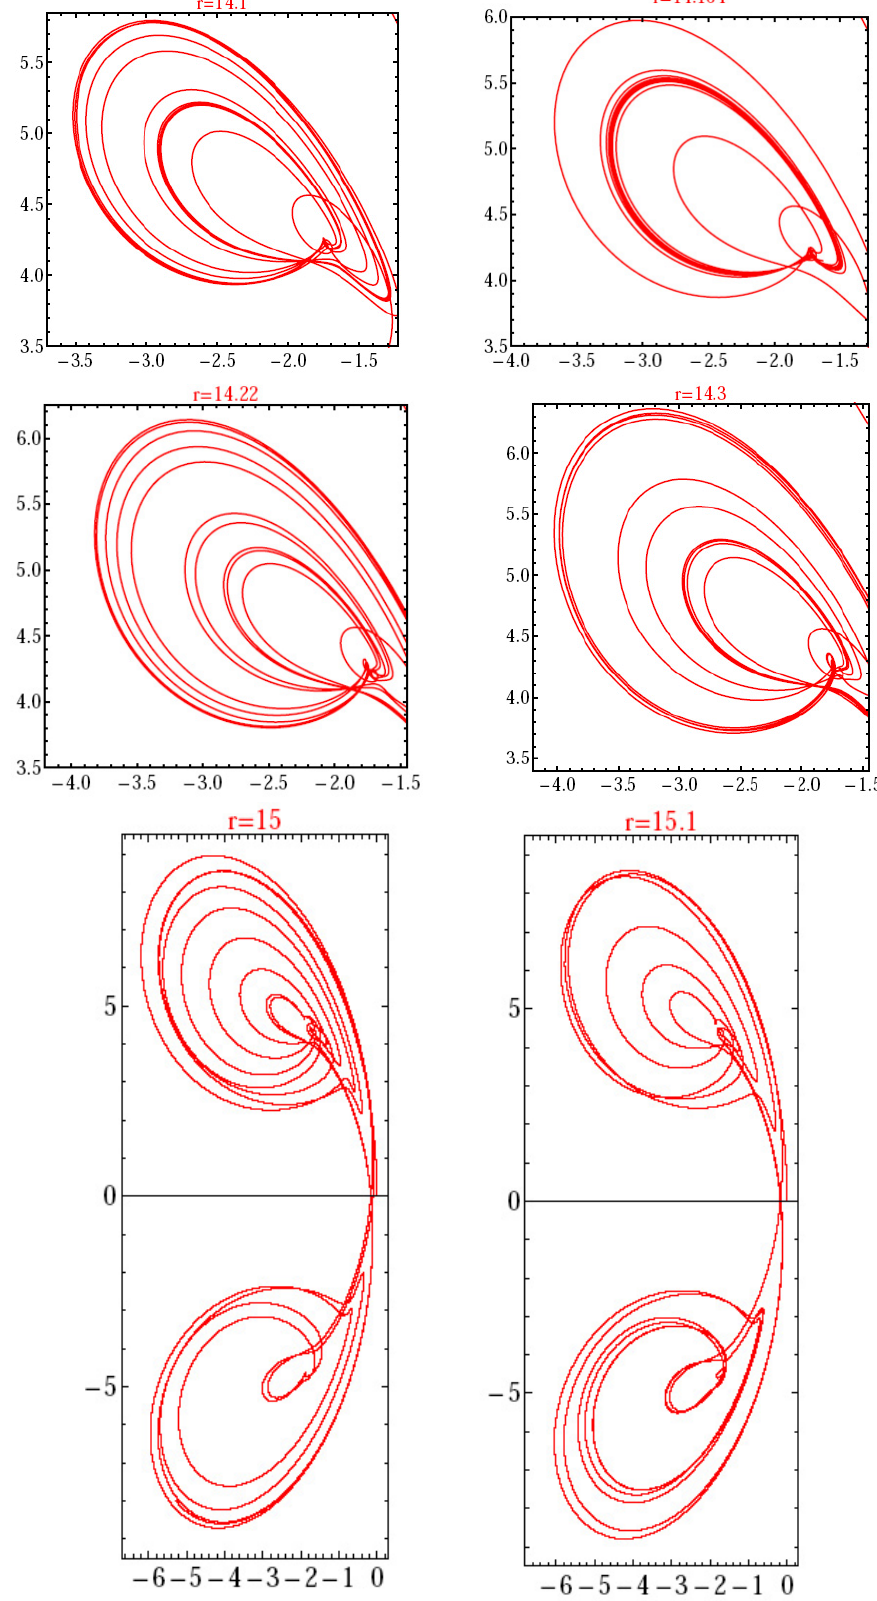
Figure 6. The hyper-chaotic situation in the case of the φ 6 − φ 9 plane versus different values of r